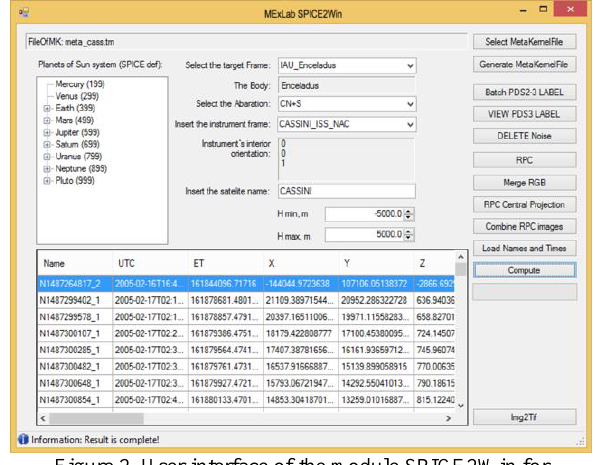
Figure 2. User interface of the module SPICE2Win for calculations of orientation parameters.